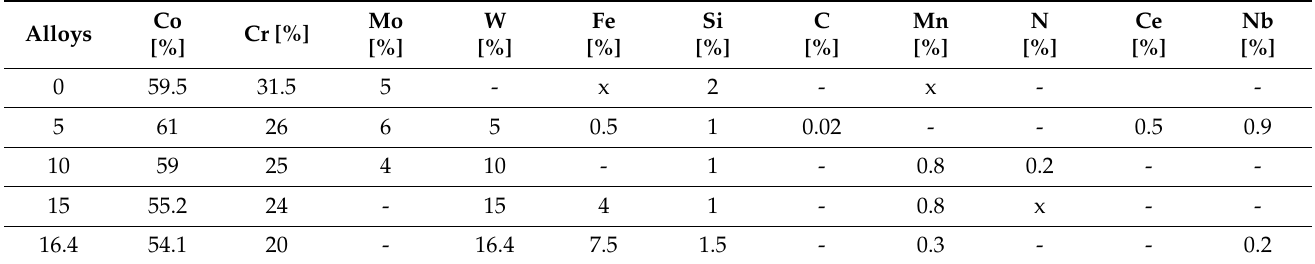
Table 1. Chemical composition of the experimental Co–Cr alloys; (x—content ≥ 1%, - chemical